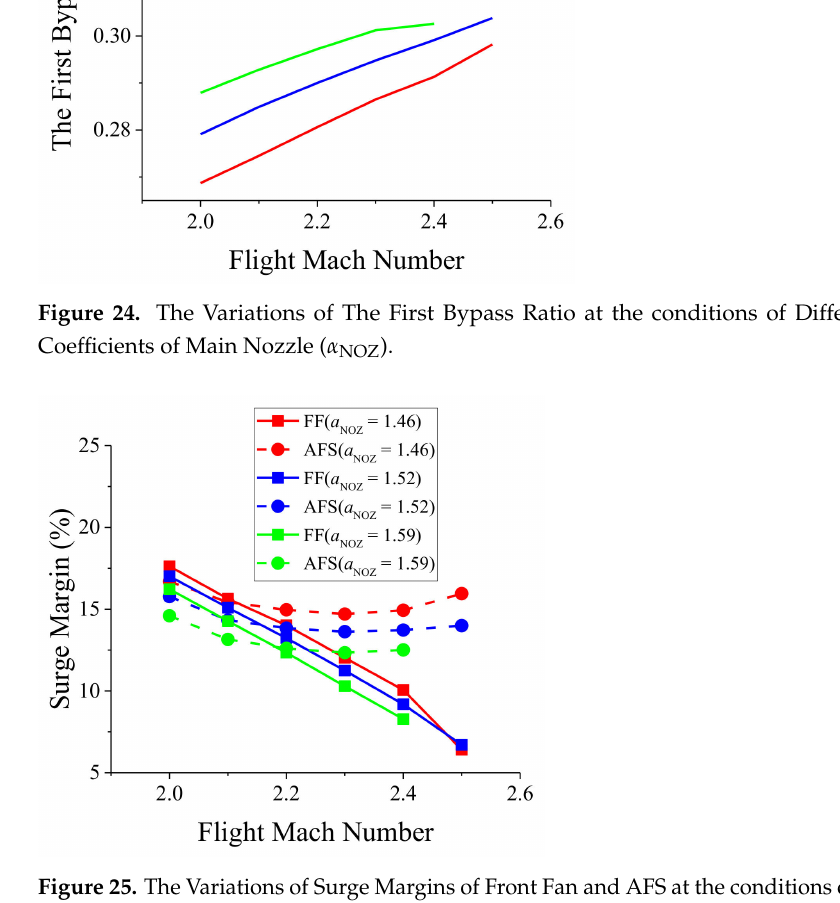
Figure 25. The Variations of Surge Margins of Front Fan and AFS at the conditions of Different Throat Area Coefficients of Main Nozzle ( α NOZ